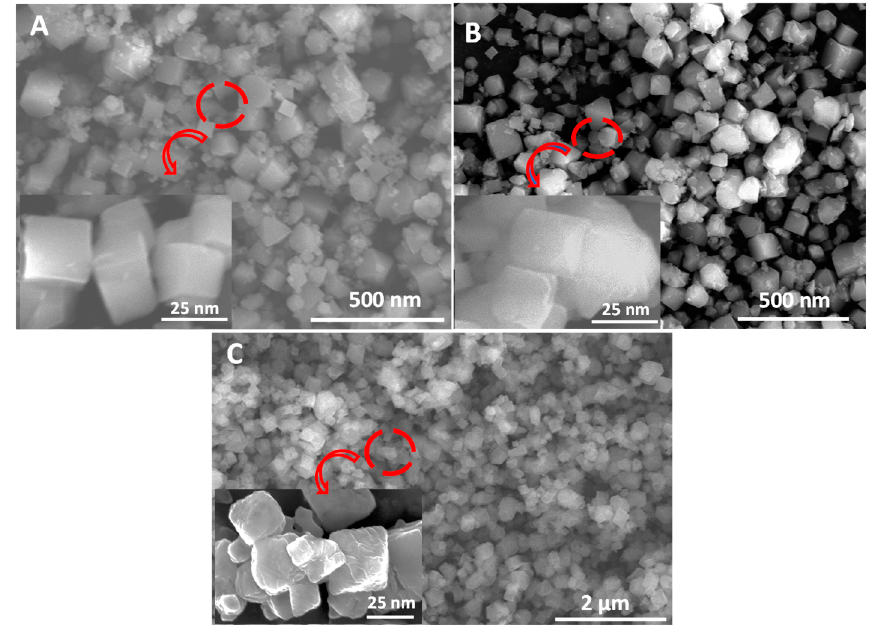
Figure 3. SEM images of MOFs synthesized using a stainless steel reactor ( A ) Cu(II)BTC; ( B ) Cu(I / II)BTC reduced from Cu(II)BTC; and ( C ) direct synthesis of Cu(I)EDS.